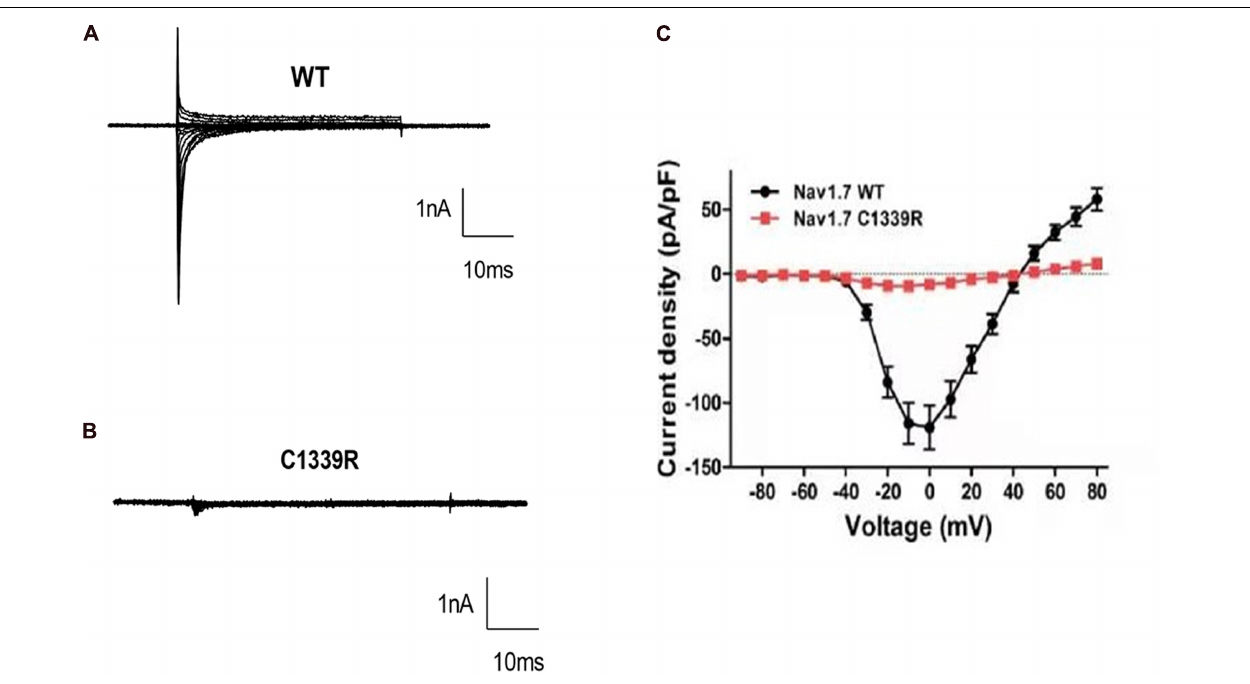
FIGURE 3 | Biophysical characterization of WT and mutant Nav1.7 channels in HEK293 cells. (A,B) Representative inward current traces were recorded from HEK293 cells expressing WT, and mutant p. Cys1339Arg Nav1.7 channels, respectively. (C) Current-voltage relationship of WT and mutant p. Cys1339Arg channels. Peak current density normalized to membrane capacitance is presented as the mean ±